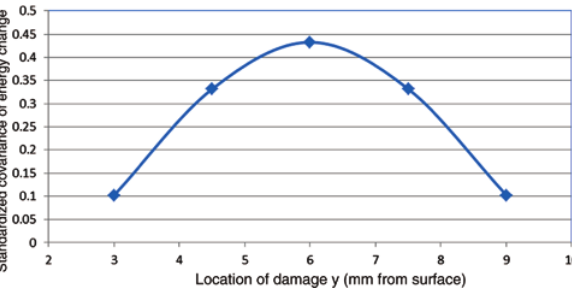
Figure 30: Convergence study of covariance of energy change of damaged beam based on window size.